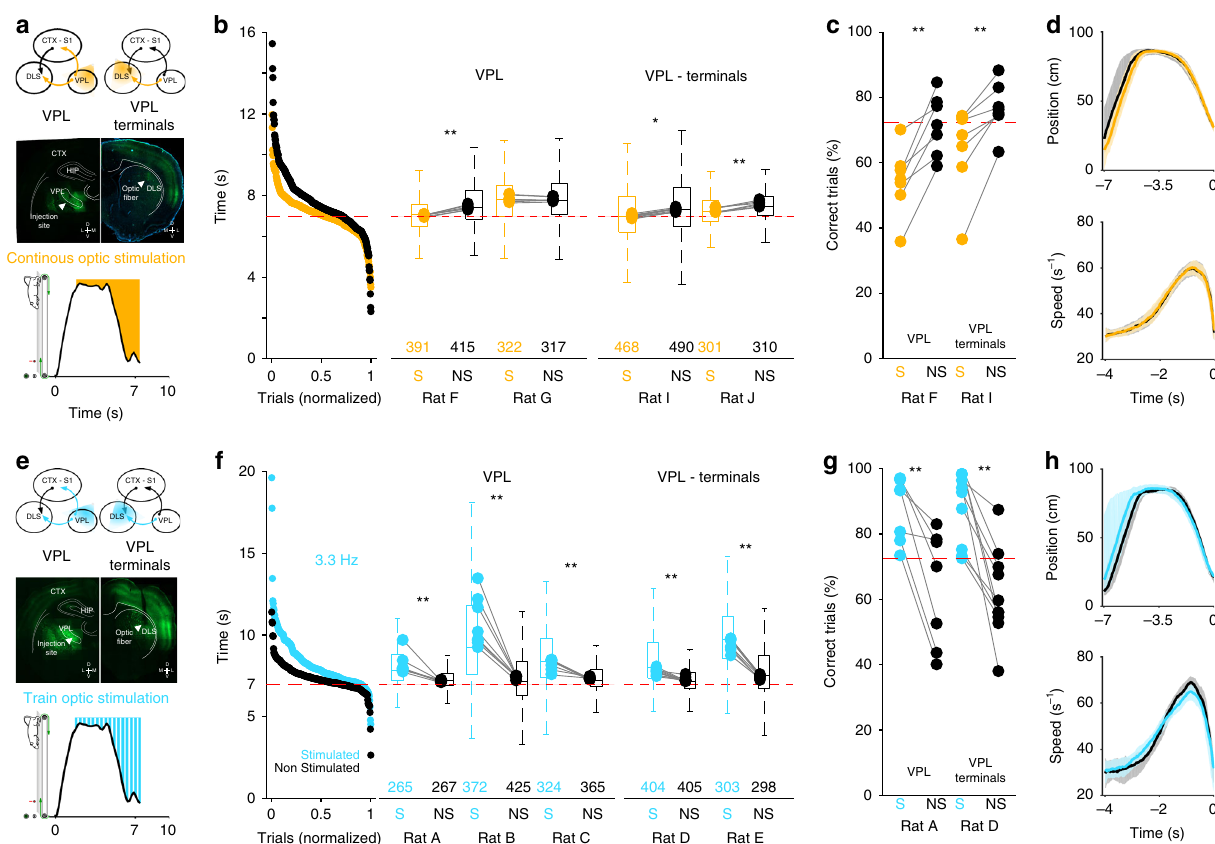
Fig. 7 Effects of optogenetic manipulation of VPL or its terminals. Schematic representation of the infection and stimulation sites ( a , e top). Histological con fi rmation of viral expression and optical fi ber positions in the VPL and DLS ( a , e , middle). Schematic representation of the moment when the stimulation was delivered during 50% of the randomly selected trials ( a , e , bottom). b , f Entrance times for all stimulated (yellow for Halorhodopsin or Archaerhodopsin; blue for Channelrhodopsin-2) vs. nonstimulated (black) trials; box plots indicate the median (25th and 75th percentiles) of the stimulated vs. nonstimulated trials; pairs of dots united by lines indicate medians of each session for each animal; the number of trials analyzed for each animal and condition is indicated at the bottom. c , g Percentage of correct trials for one animal on each group. d , h Average position (top) and speed (bottom) trajectories for all stimulated and non-stimulated trials of Rat F ( d ) and Rat A ( h ). **Wilcoxon rank-sum test p <